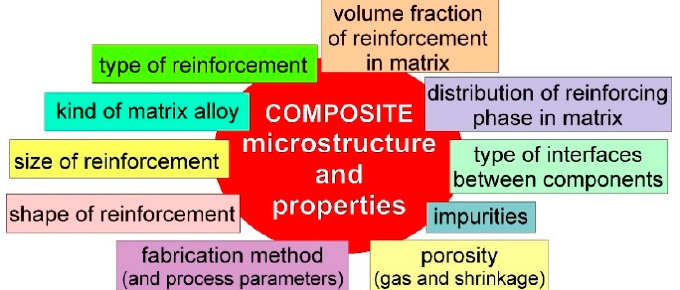
Figure 1. Scheme of factors influencing microstructure and properties of composites.